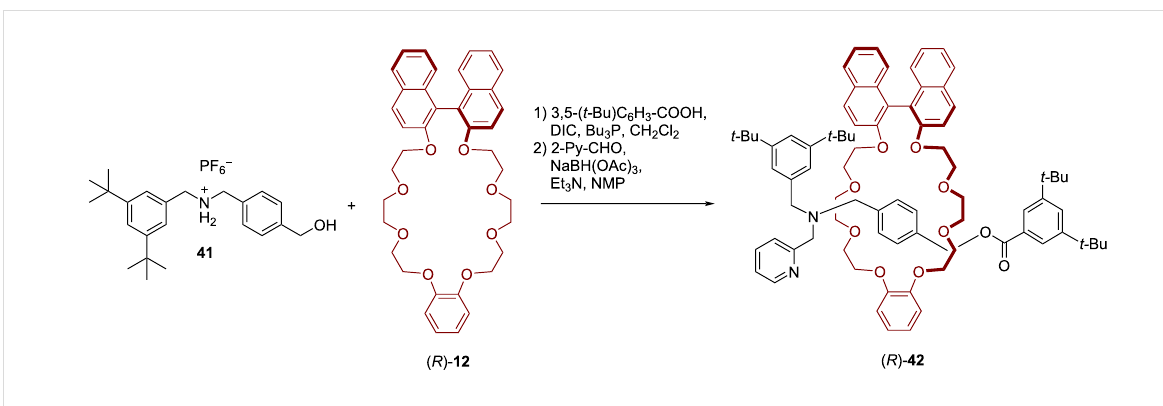
Figure 10: Synthesis of Takata´s pyridine-based [2]rotaxane ( R )- 42 .